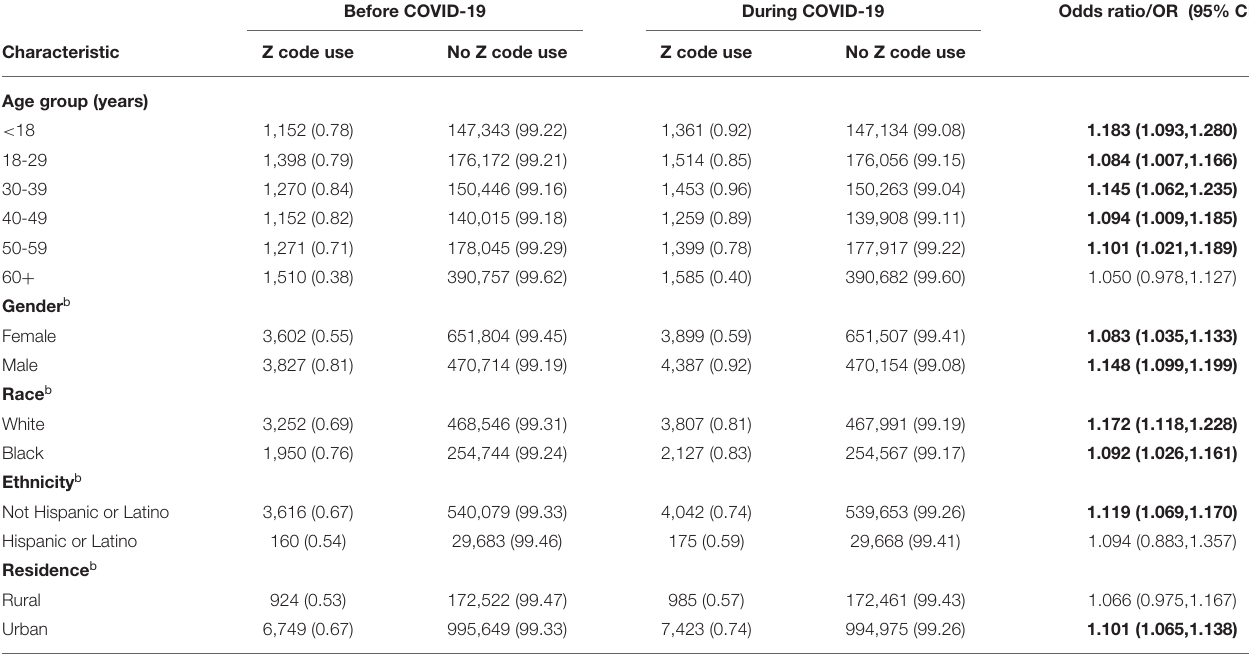
TABLE 3 | Z code use over time: Before and during COVID-19 (N = 1,190,531). Before COVID-19 During COVID-19 Odds ratio/OR (95% CI)